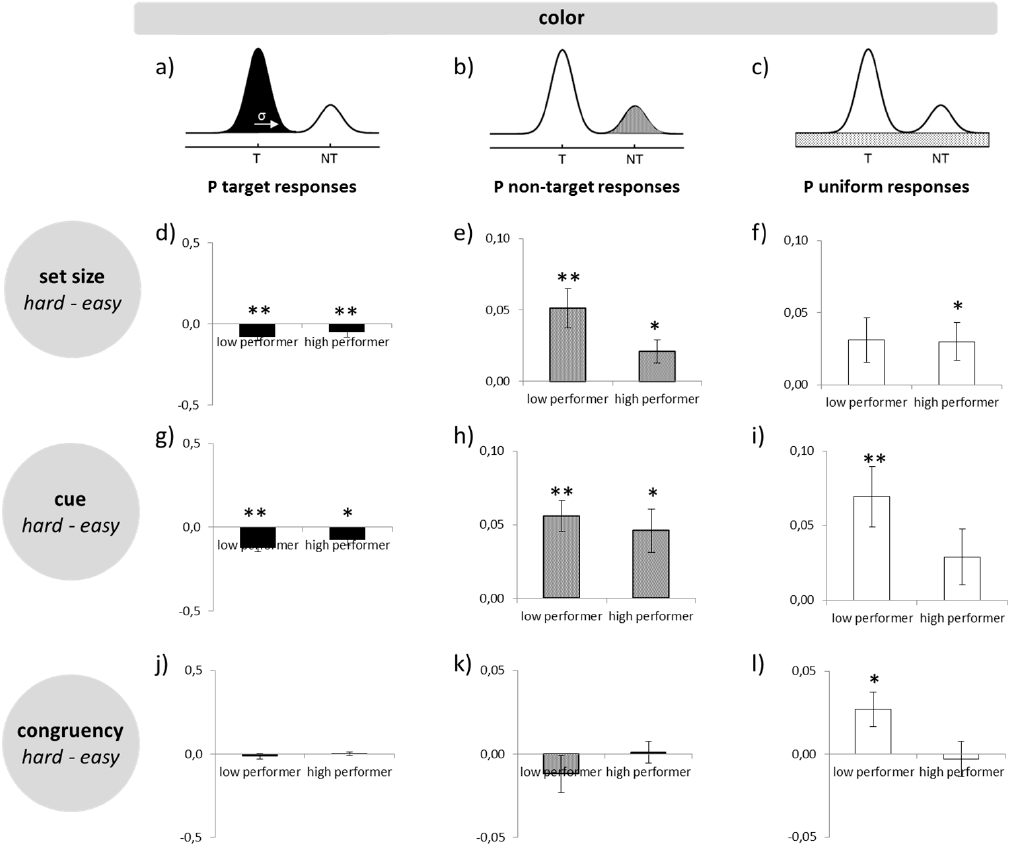
Figure 3. Distribution of errors from the precision task for orientation and color: ( a – c ) schematic illustration of error contributions; ( d – f ) di ff erence between set size 2 and set size 4 separated by performance group and error source; ( g – i ) di ff erence between pre-cue and post-cue separated by performance group and error source; ( j – I ) di ff erence between incongruent and congruent separated by performance group and error source. ∗ = p ≤ 0.05; ∗∗ = p ≤ 0.01.